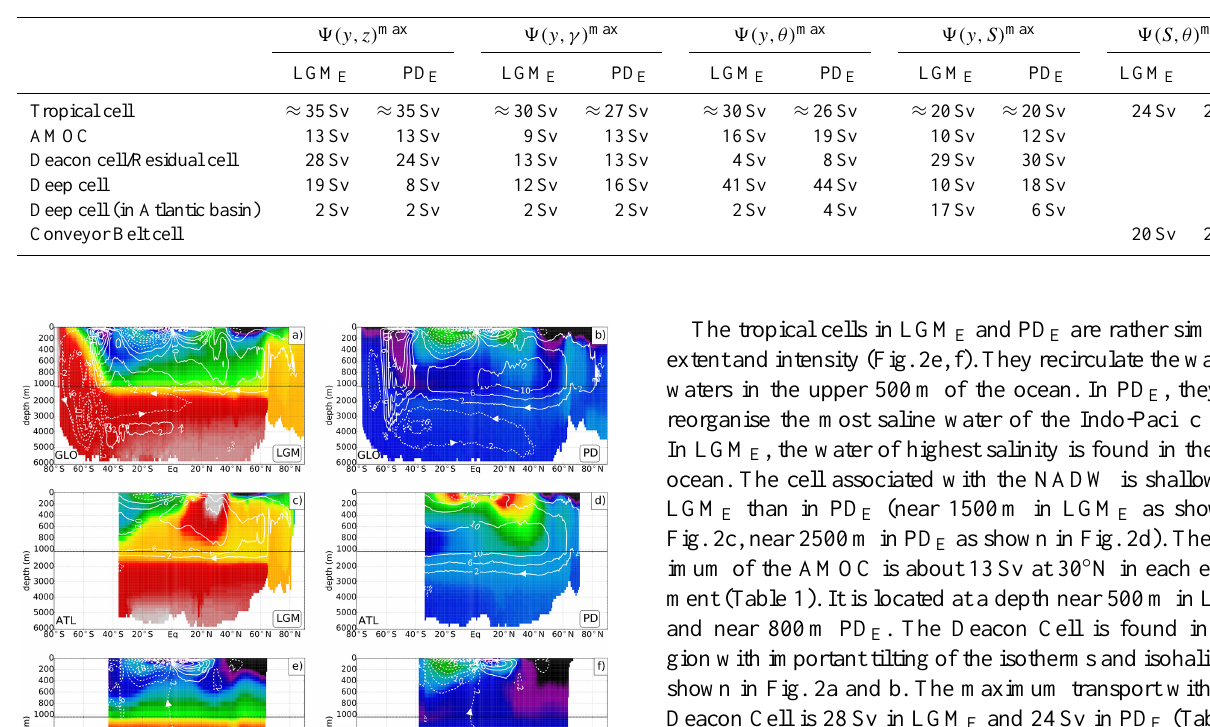
Table 1. Maximum volume transport in the LGM E and PD E simulations in the tropical cells, the AMOC cell, the Deacon Cell, the deep cell representative of the AABW (in the Atlantic basin and the global ocean) and the Conveyor Belt cell for the different coordinates frameworks.